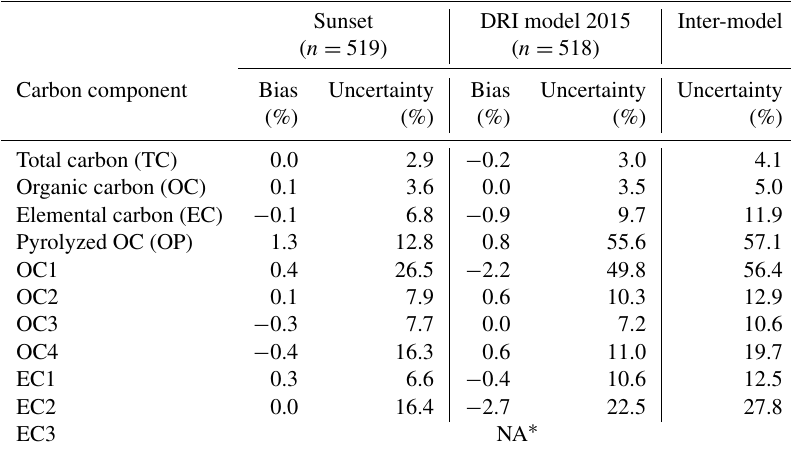
Table 3. Within-model replication bias and uncertainty estimated from the scaled relative difference of the replicate analyses by Sunset and DRI model 2015 analyzers, as well as the inter-model uncertainty calculated from the within-model replication uncertainties in the individual